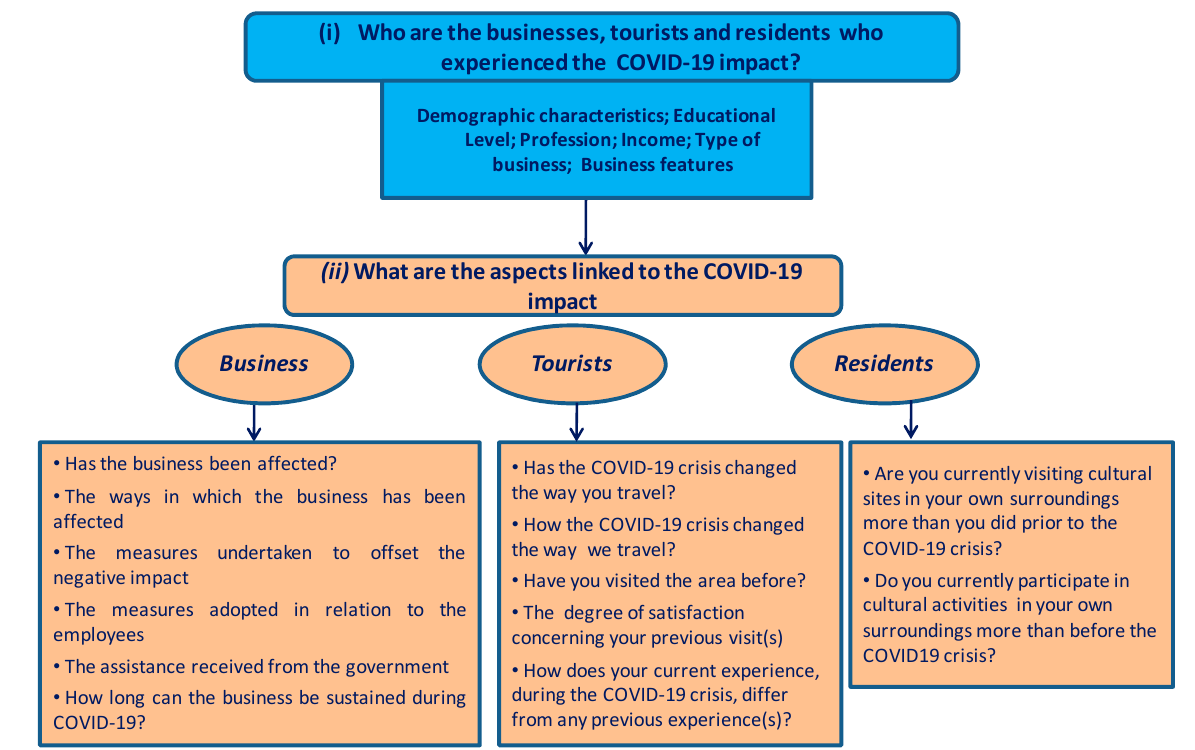
Figure 6. The description of the questions included in the surveys.